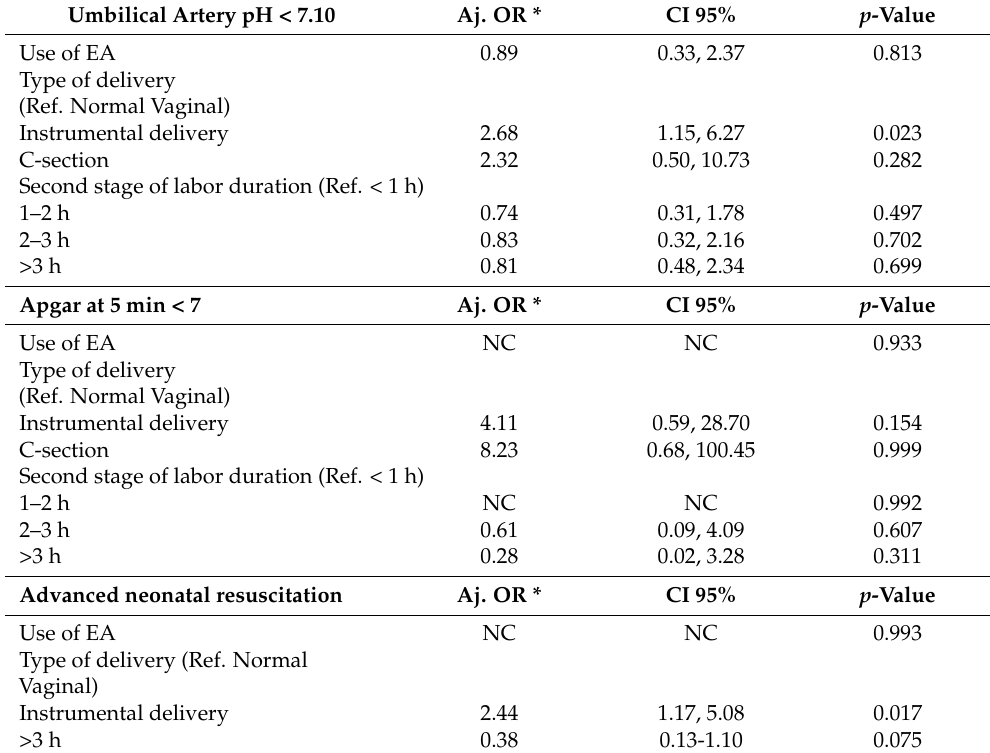
Table 4. Multivariate analysis on the use of epidural analgesia, type of delivery, duration of the second stage of labor and its link with neonatal morbidity in population